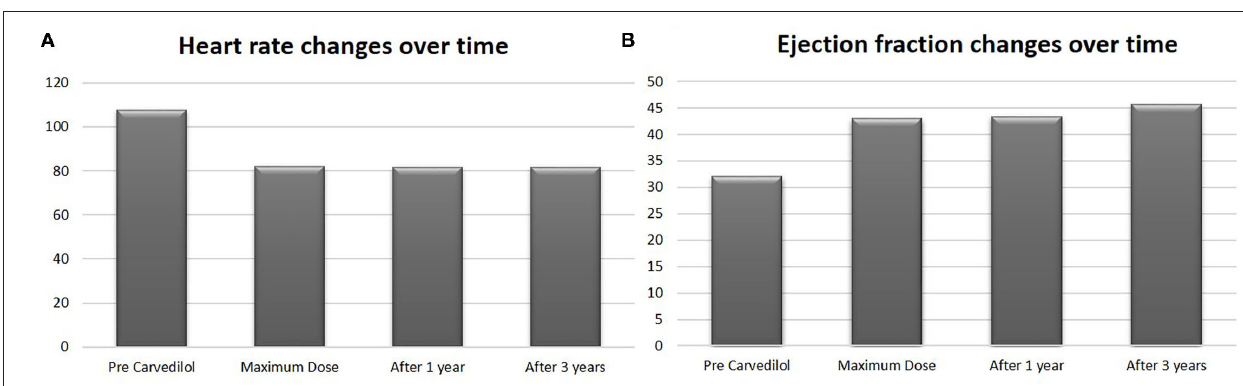
by log-rank analysis, confirming how survival is significantly better in the treated group, especially in the long-term